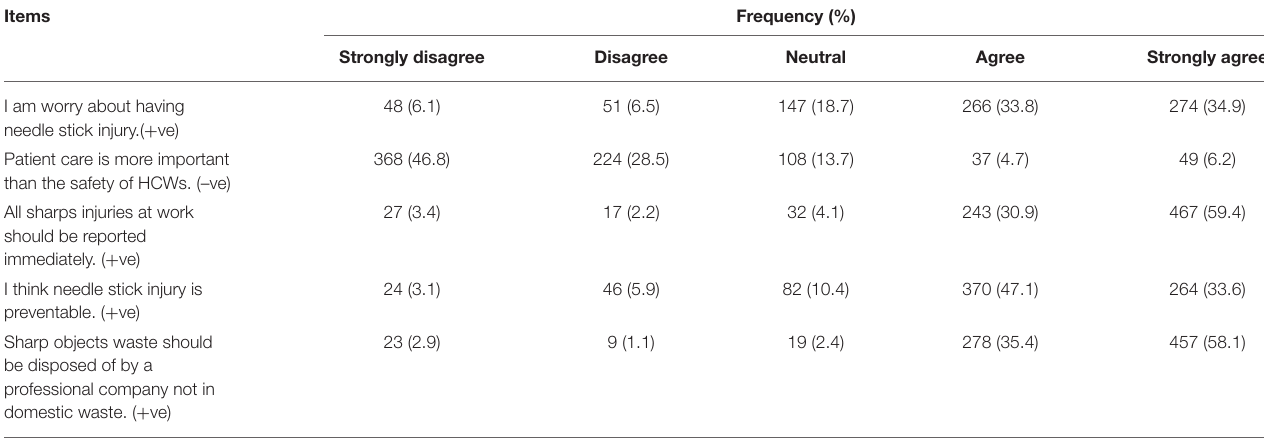
TABLE 5 | Responses to the attitude statements.